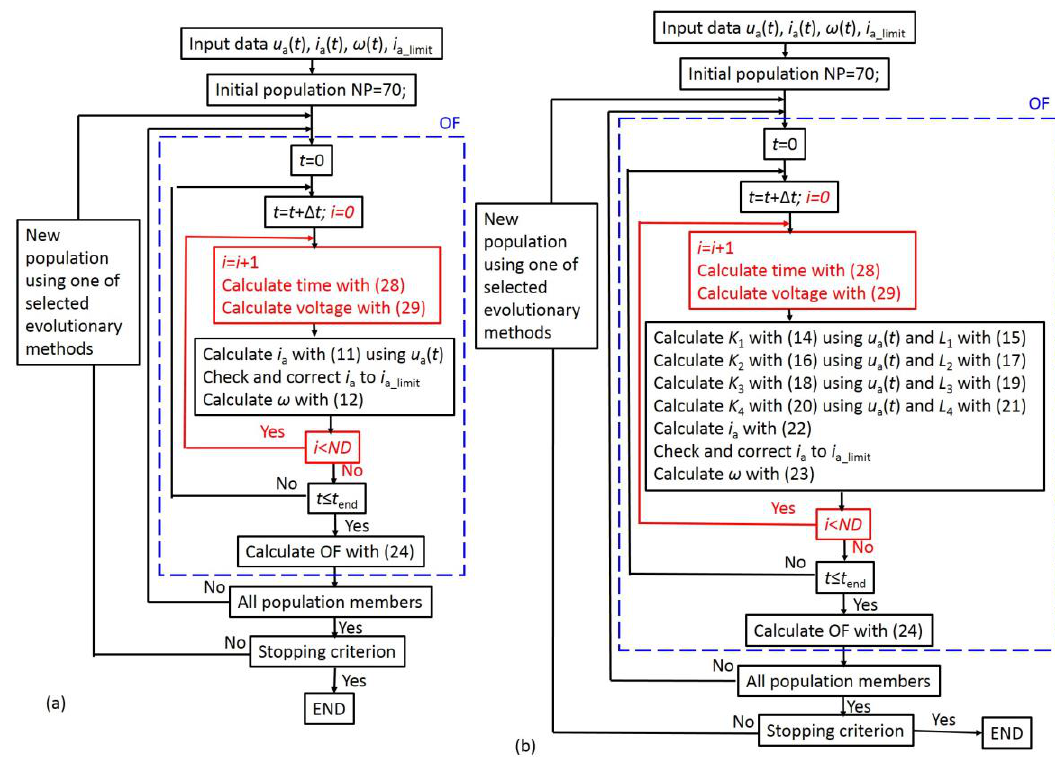
Figure 17. Algorithm for parameter determination using a time step division for: ( a ) EM5 ( ND = 5) or EM10 ( ND = 10); ( b ) RK5 ( ND = 5) or RK10 ( ND = 10).